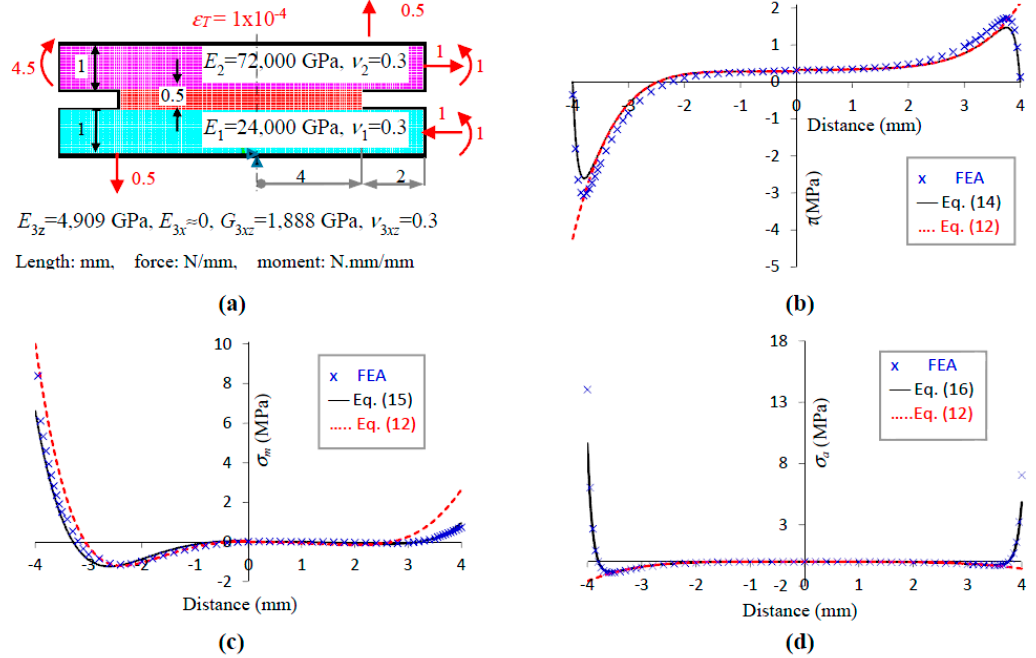
Figure 3. Numerical validation: ( a ) model; ( b ) τ ( x ); ( c ) σ m ( x ) and ( d ) σ a ( x ). Table 1. Numerical validation: characteristics of the unbalanced structure.